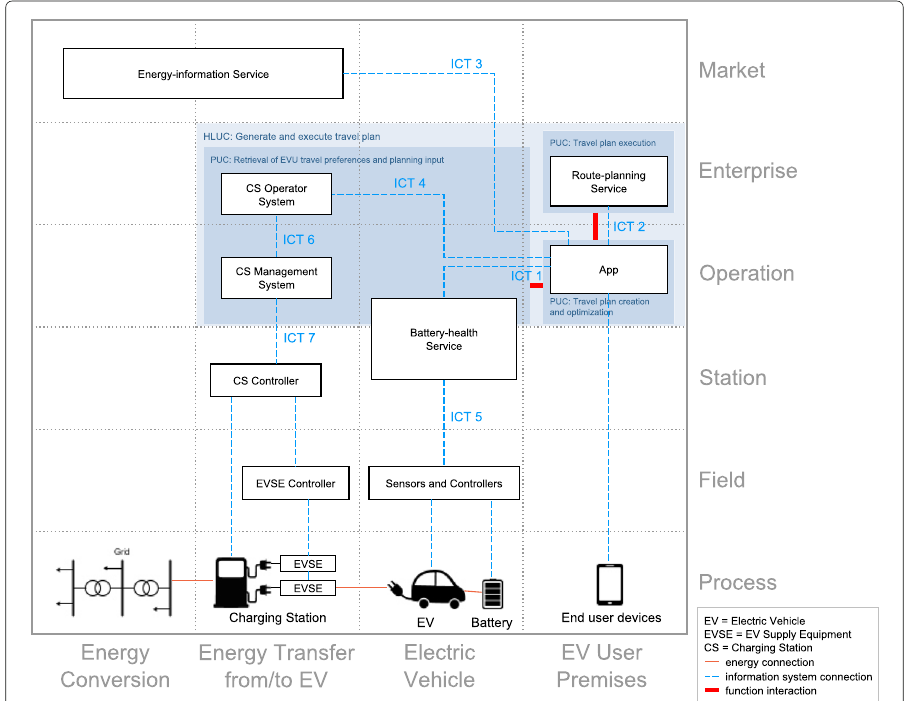
Fig. 12 Mapping of considered High Level UC to the component, information and communication layers of EMSA